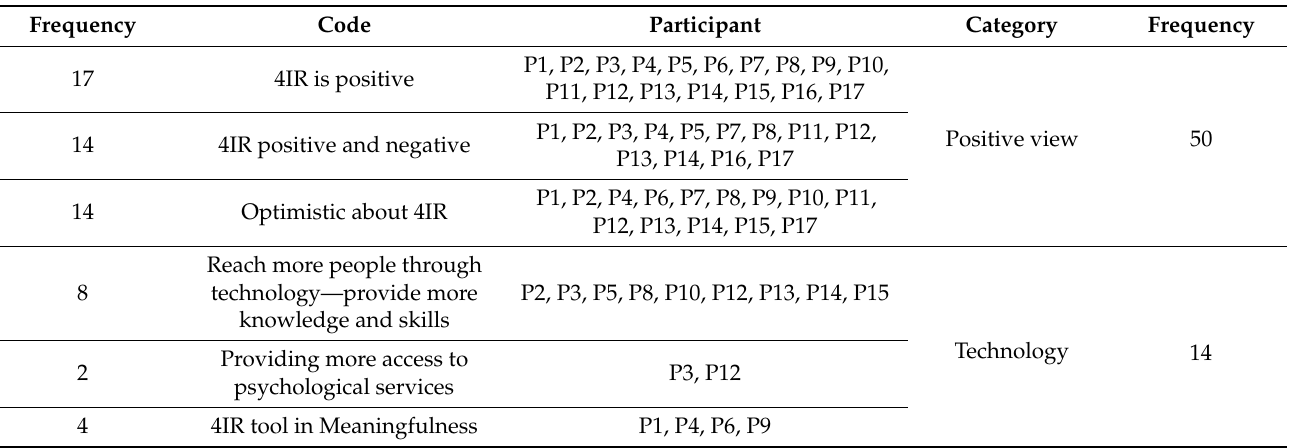
Table 3. Meaningfulness of the 4IR Perceived by